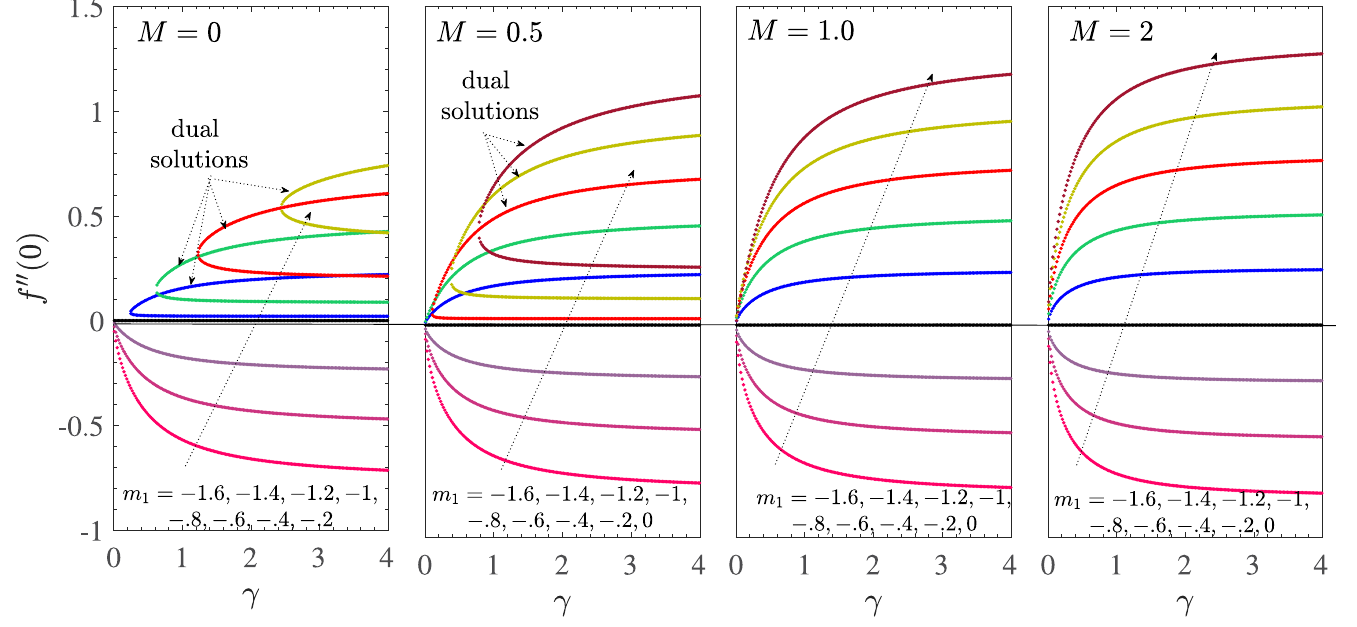
Fig 5. f 00 (0) vs γ for V c = 2, γ 1 = 0.1 = − γ 2 , d = − (1+ m 1 ) for the shrinking sheet case with mass